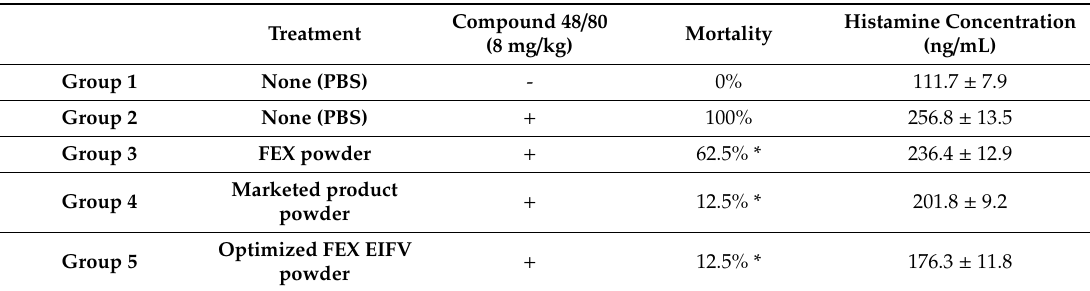
Table 7. E ff ect of pure drug, marketed product and optimized formulation on the compound 48 / 80 induced systemic anaphylactic reaction in mice ( n = 8) with